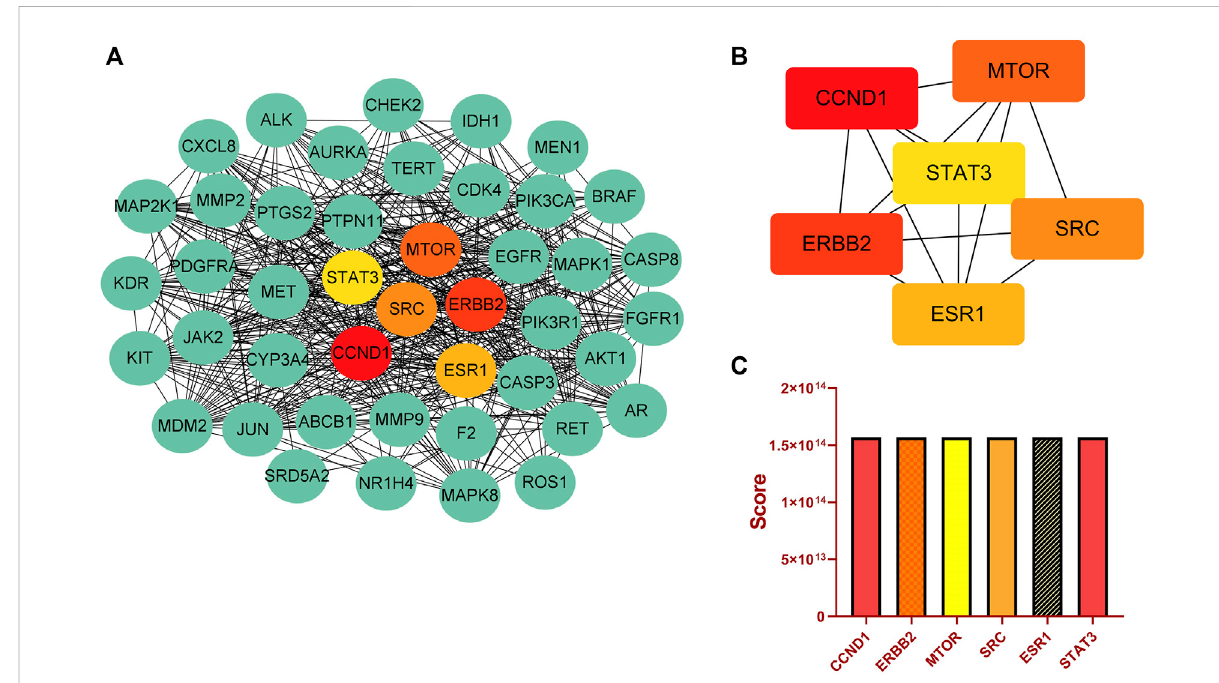
FIGURE 3 Key targets analysis. (A) PPI network. (B) Top six key targets derived from cytoHubba ’ s MCC algorithm. (C) Scores for the top six key targets.